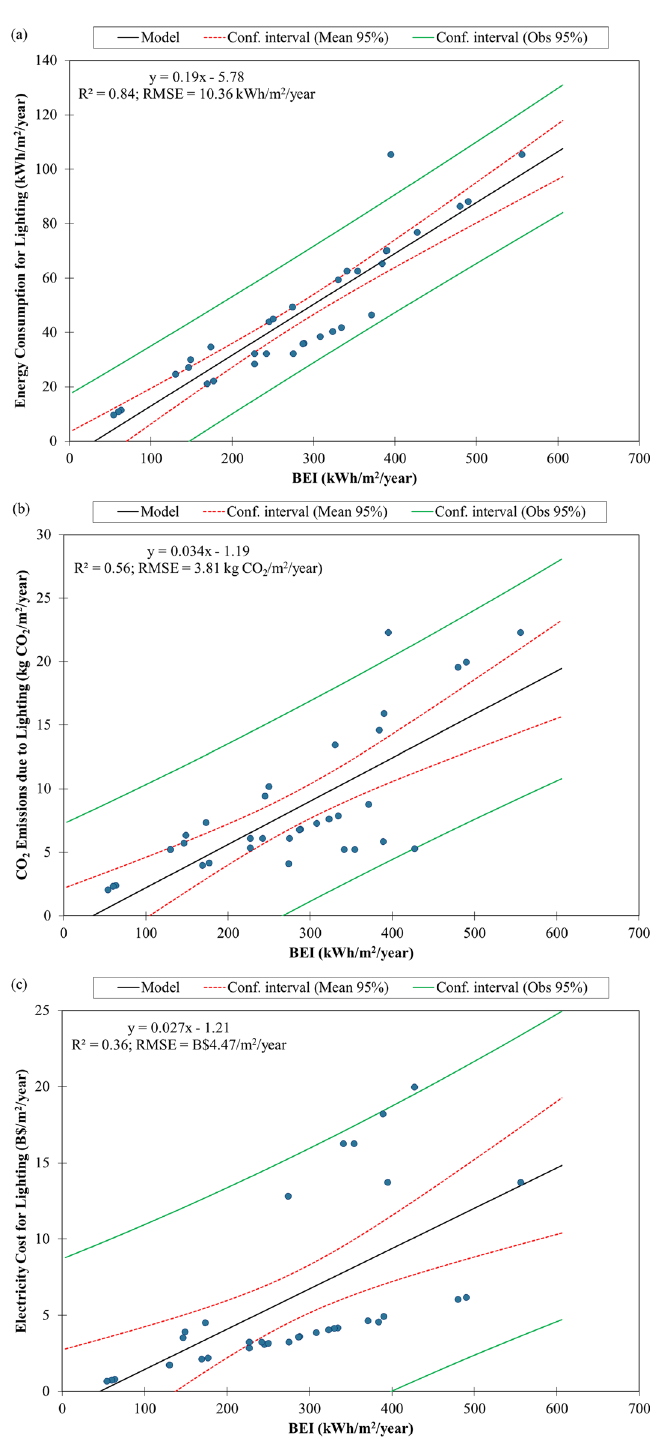
Asia with 95% confidence